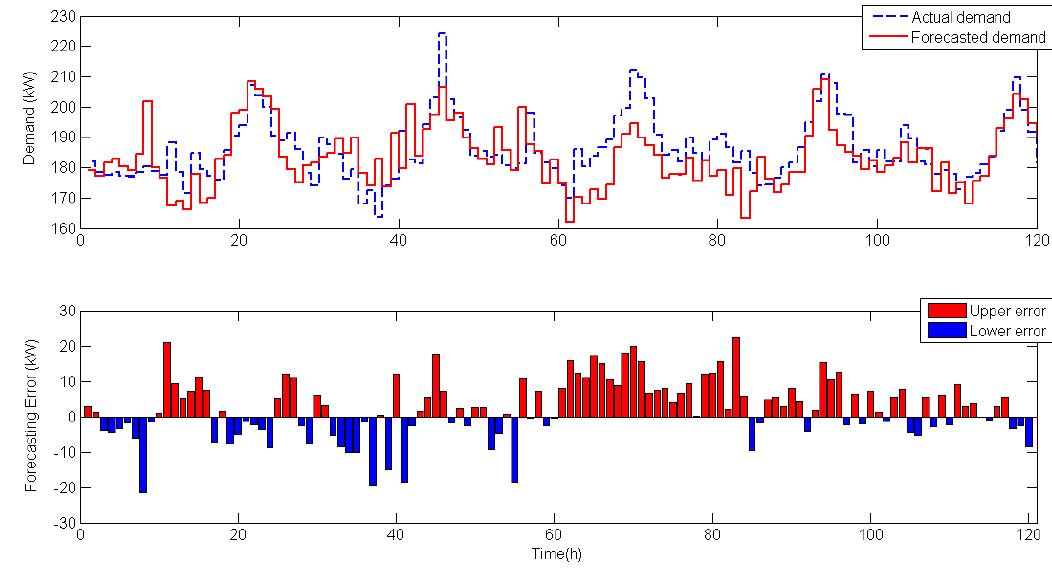
Figure 2. Operational results from August 14 to 18, 2015 in an MG in Gasa Island, Korea.